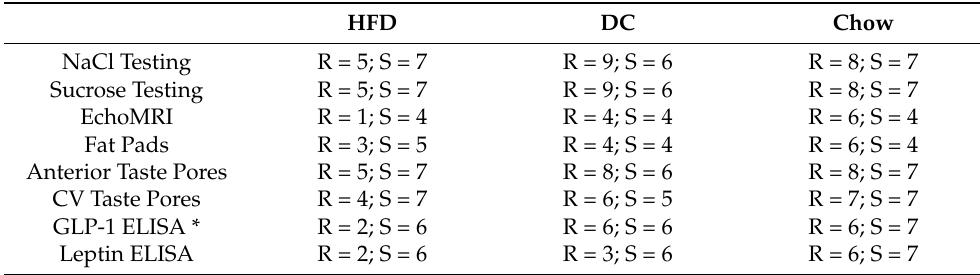
Table 2. Group sizes for statistical